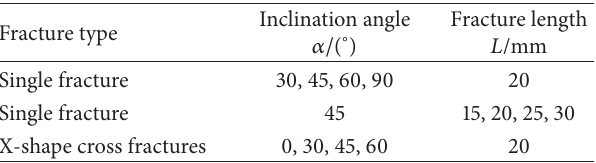
Table 1: Geometric parameters of fractured